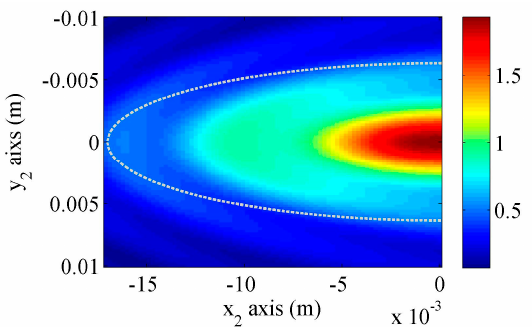
Figure 5. Longitudinal wave field distributions underneath the wedge generated by a uniform distributed contact transducer. Attenuation in the wedge is neglected.